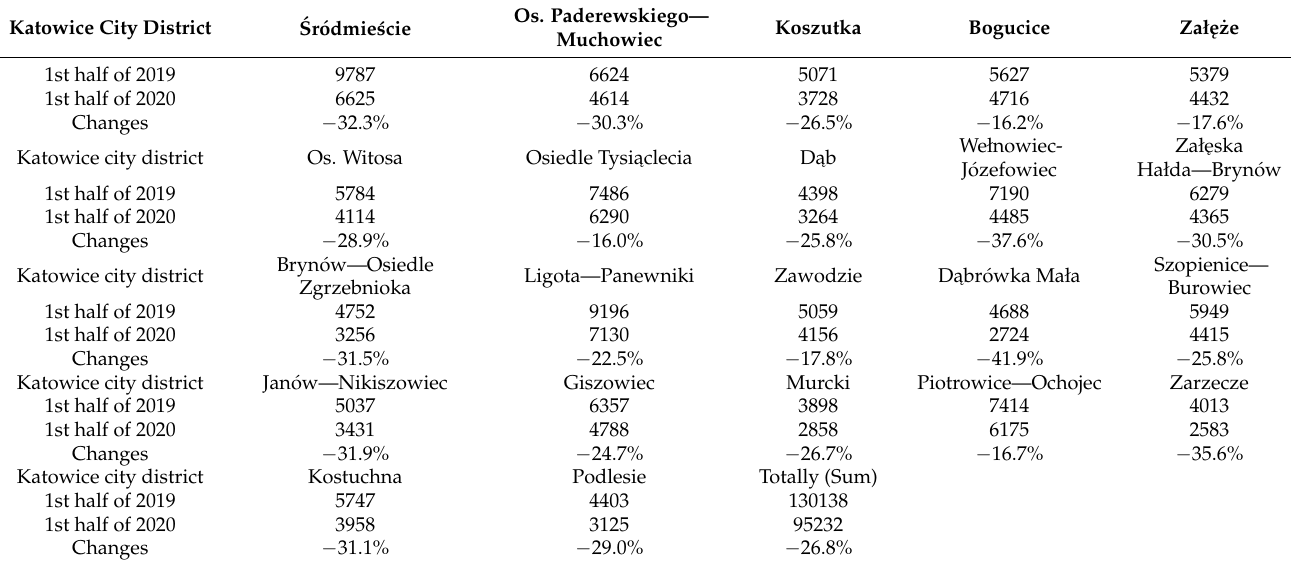
Table 2. Changes in the number of trips ending in the districts of the city of Katowice during the morning rush hour (6:00–9:30).